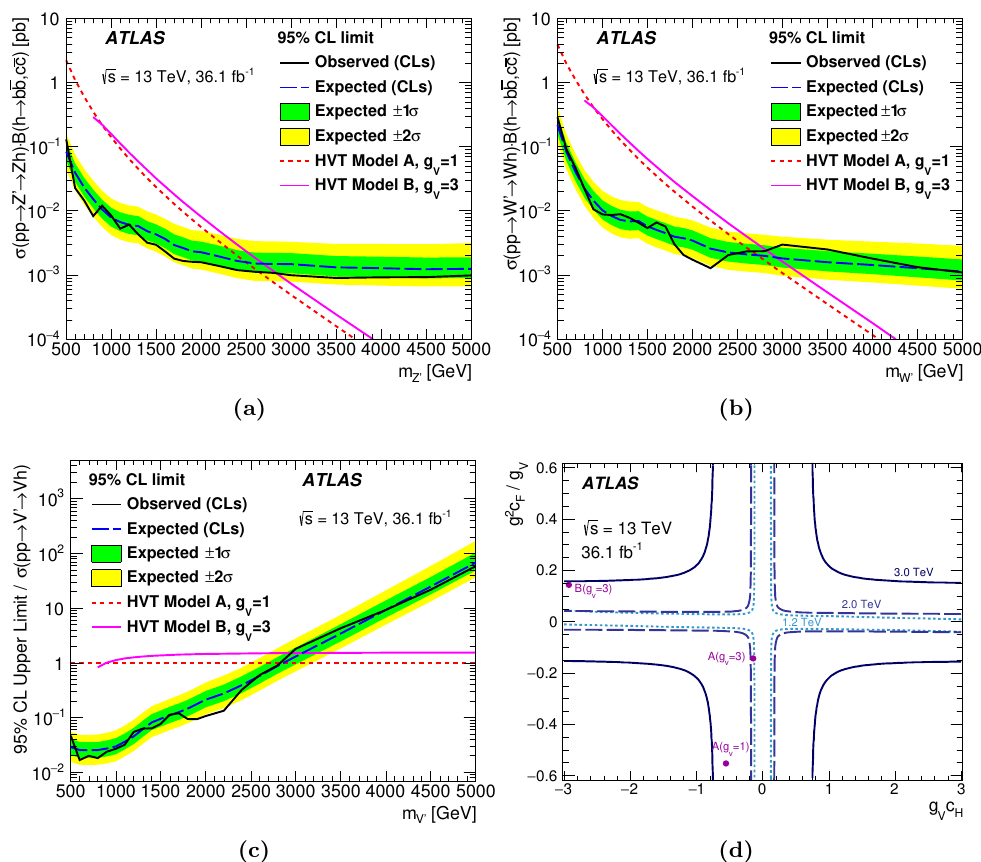
Figure 5. Upper limits as a function of the resonance mass at the 95% CL for (a) the production cross-section of Z 0 times its branching fraction to Zh and the branching fraction B ( h ! b (cid:22) b; c (cid:22) c ) and (b) the production cross-section of W 0 times its branching fraction to Wh and the branching fraction B ( h ! b (cid:22) b; c (cid:22) c ). (c) Upper limits at the 95% CL for the scaling factor of the production cross-section for V 0 times its branching fraction to Wh=Zh in Model A . The production cross-sections predicted by Model A and Model B are shown for comparison in (a){(c). (d) Observed 95% CL exclusion contours in the HVT parameter space f g V c H , ( g 2 =g V ) c F g for resonances of mass 1.2 TeV, 2.0 TeV and 3.0 TeV. The areas outside the curves are excluded. Also shown are the benchmark model parameters A( g V = 1), A( g V = 3) and B( g V = 3).